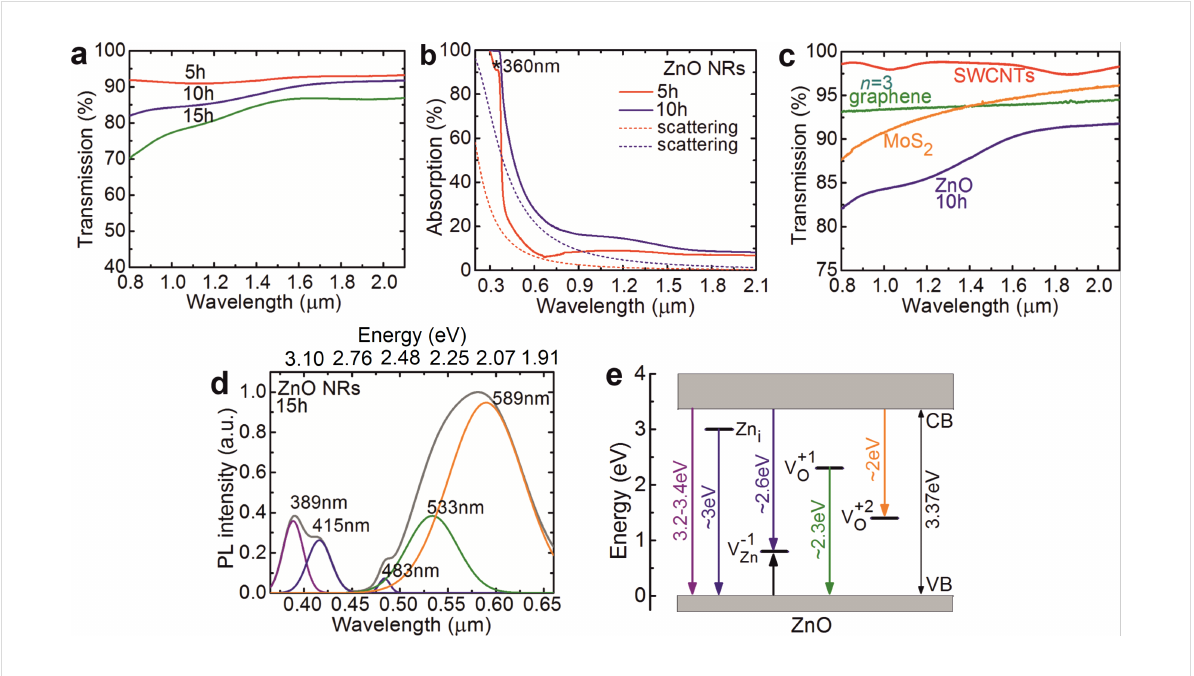
Figure 3: (a) Small-signal absorption spectra of the ZnO NRs grown hydrothermally on glass substrates for 5–15 h, T (ZnO NRs) = T (ZnO NRs + sub- strate)/ T (substrate); (b) estimation of the scattering losses in ZnO NRs grown for 5 h and 10 h (dashed curves); (c) comparison of the small-signal absorption spectra of the ZnO NRs grown for 10 h, multilayer graphene with n = 3 carbon layers, multilayer MoS 2 film [31] and SWCNT/PMMA film [32]; (d) room temperature photoluminescence (PL) spectrum of ZnO NRs grown for 15 h, the excitation wavelength is 0.350 µm: grey curve – the measured PL spectrum, color bands – decomposition of the PL spectrum into Gaussian components; (e) scheme of the defect states in the bandgap of ZnO (the color of arrows corresponds to the color of the emission bands in (d).